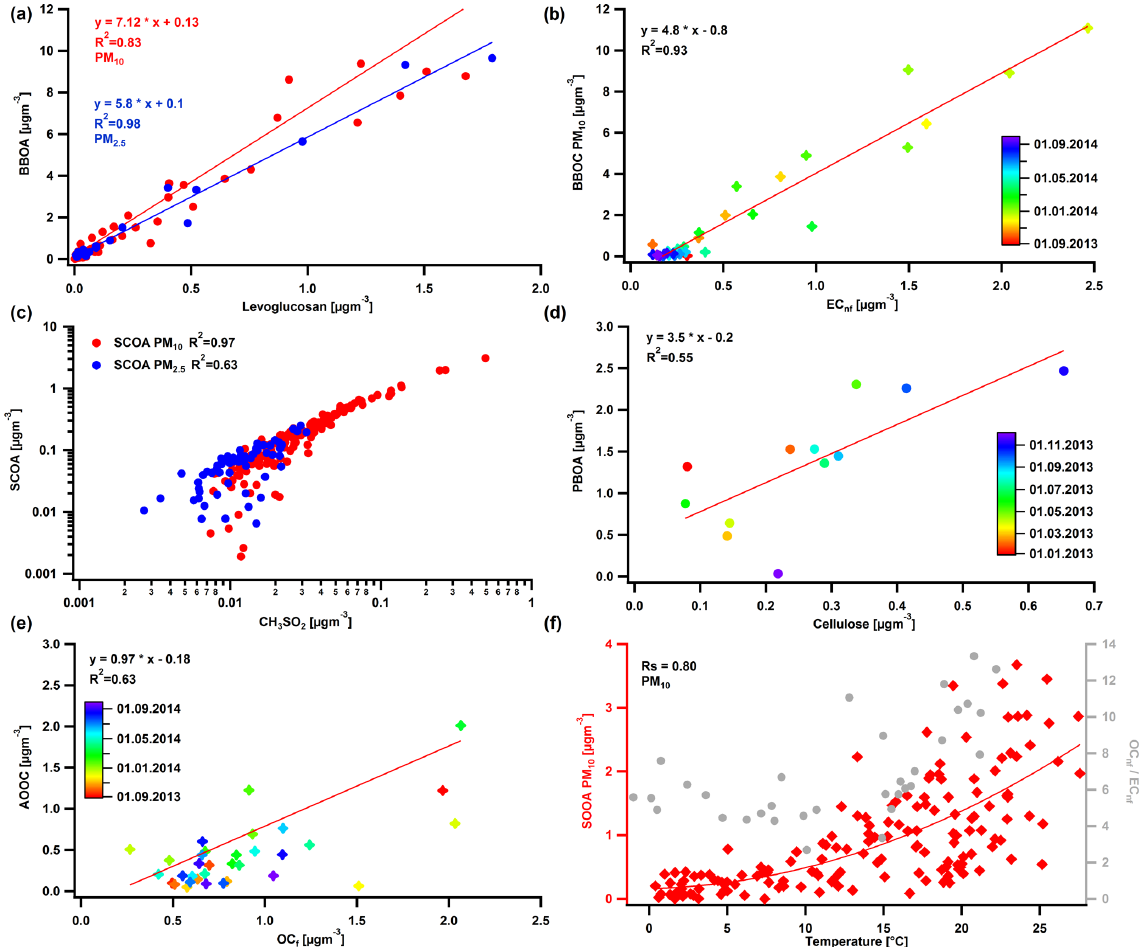
Figure 7. Correlations between BBOA and levoglucosan for the two size fractions (a) , BBOC and EC nf for PM 10 (b) , SCOA and CH 3 SO + for the two size fractions (c) (the regression lines show a linear relationship), PBOA and cellulose for PM 10 (d) , AOOC and OC f (the regression fit was weighted by the standard deviation of AOOC) (e) , and SOOA and daily averaged temperature as well as OC nf / EC nf ratio and temperature for PM 10 (f)